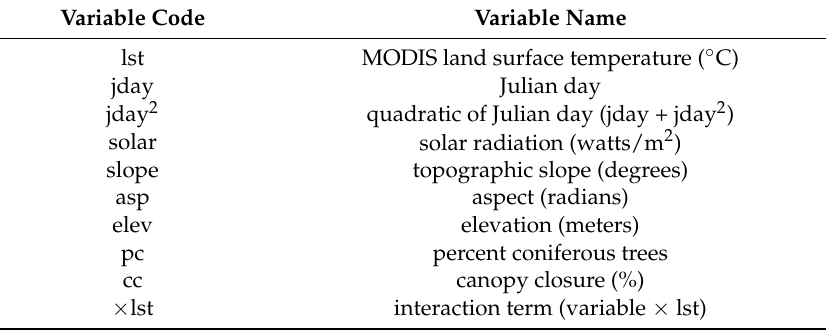
Table 2. Conventional explanatory variables used for modeling understory temperature.